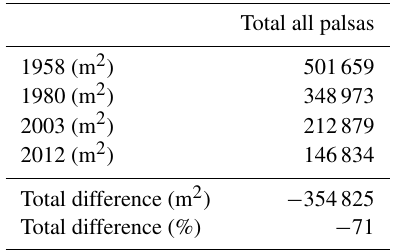
Table 4. Area of all palsas in Goatheluoppal for 1958, 1980, 2003 and 2012, with total differences of the area between 1958 and